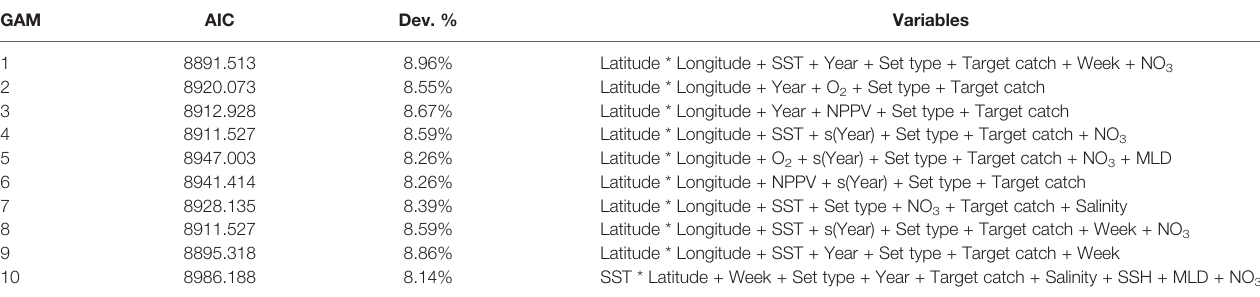
TABLE 2 | Explored GAMs candidates with corresponding Akaike Information Criteria (AIC), explained deviance (Dev. %) values and the variables selected for each model. GAM AIC